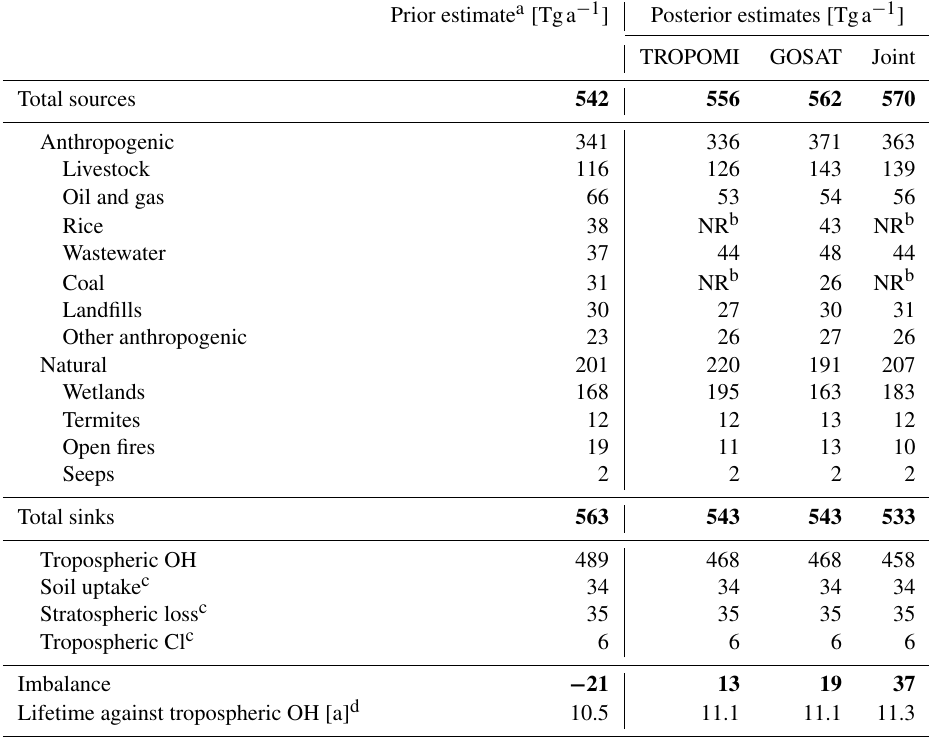
Table 1. Global methane budget for 2019.